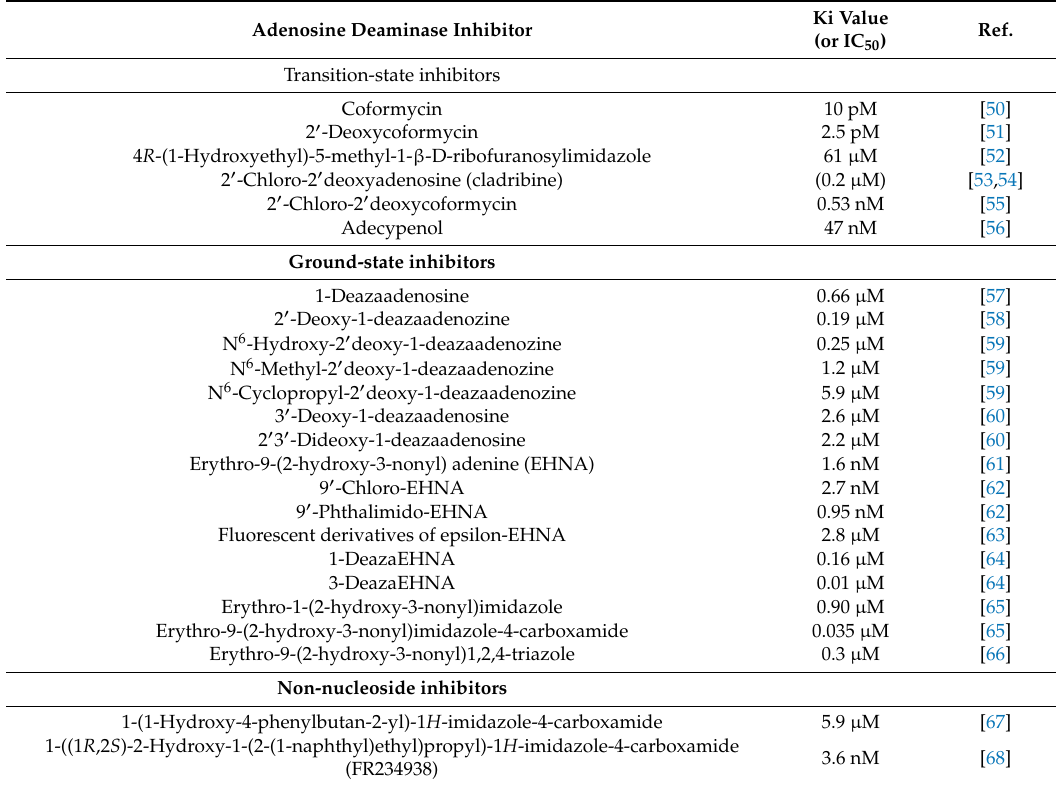
Table 1. The main classes of adenosine deaminase inhibitors with inhibitory constant (Ki) value or the half maximal inhibitory concentration (IC 50